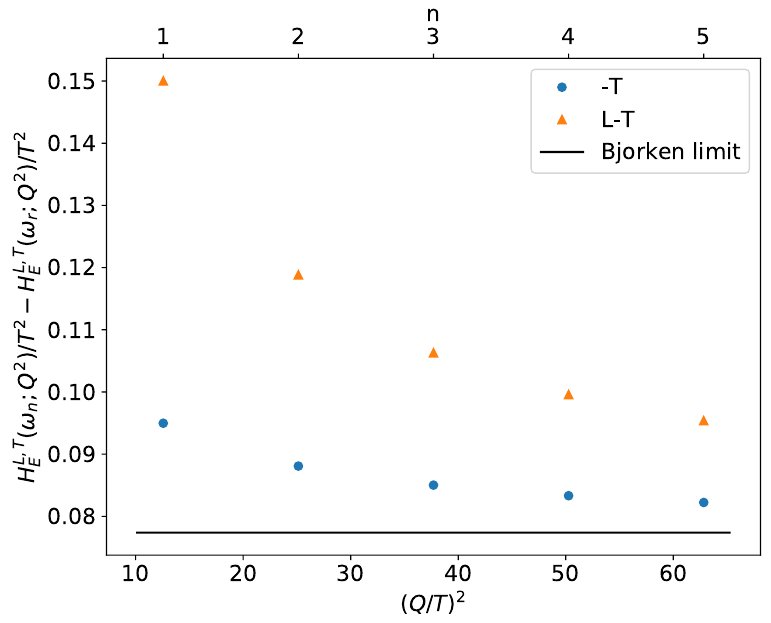
Figure 4 . Fixed-virtuality correlation functions (4.7) in the free theory, as functions of Q 2 . As we increase ω n , we set Q 2 = 2 Tω n and ω r = 2 ω n , i.e. a n = 1 and a r = 2 are kept constant. Two choices of polarization are shown, that converge to the same value in the Bjorken limit. The difference between these two polarizations measures the breaking of the Callan-Gross relation at the correlator level, up to a 1 /Q 2 suppressed term (see eq.